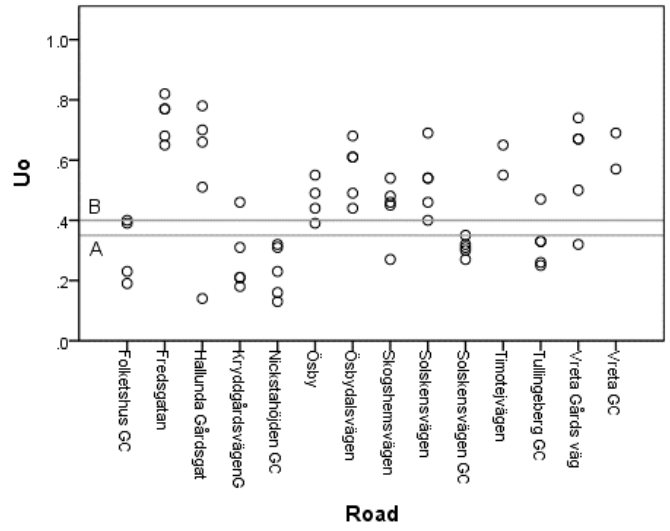
Figure 5. Overall luminance uniformity ( U o ) measured for the 14 roads studied, relative to lighting class boundaries A–B (horizontal lines). A = M6 ‐ M5/CE5/S4 ‐ S3; B = M4 ‐ M1/CE4 ‐ CE1/S2 ‐ S1, where